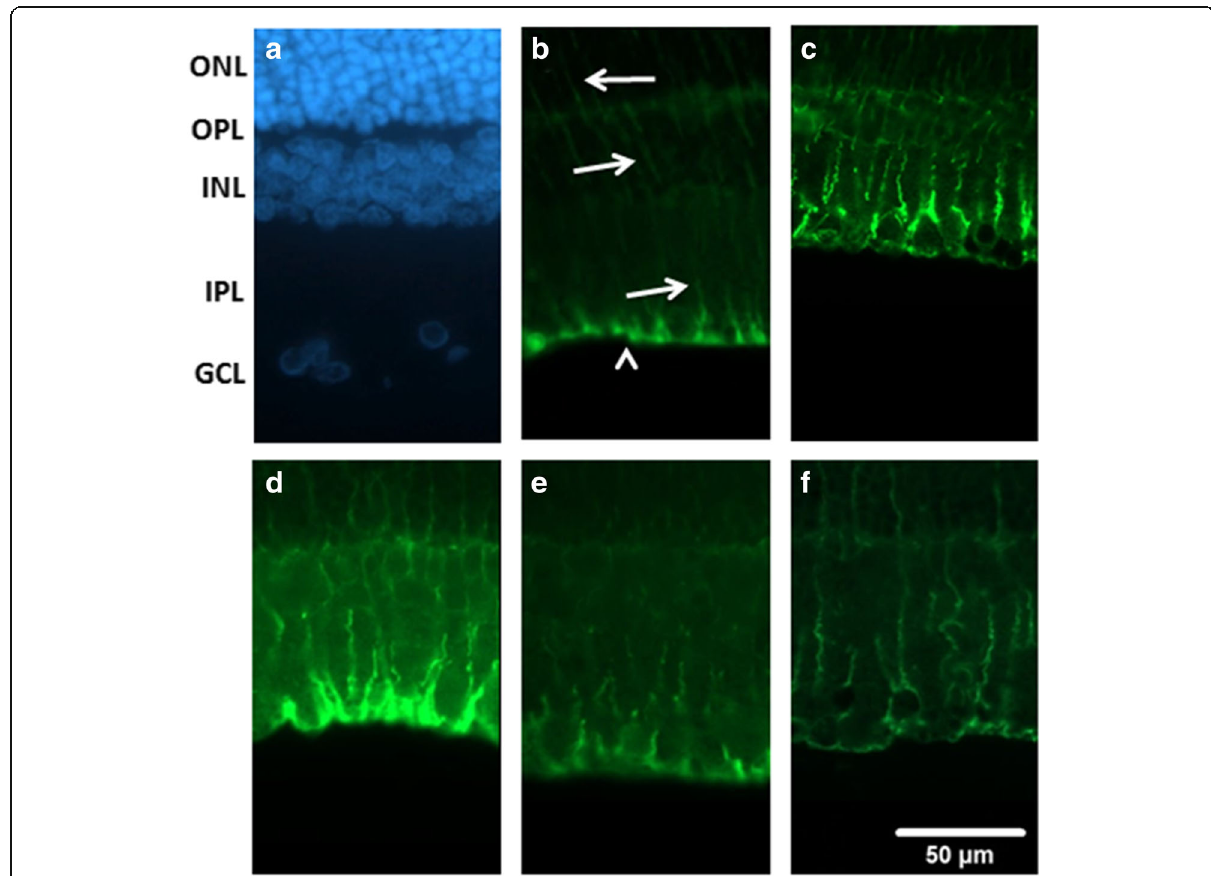
Fig. 6 Vimentin (green) immunohistochemistry. a shows the cellular nucleus of the sham retina labeled with 4,6-diamidine-2-phenylindole dihydrochloride ( DAPI, blue ). b shows a sham retina with the vimentin immunoreactivity at the end feet ( arrow heads ) in the GCL and at the processes in the IPL, INL and ONL ( arrows ). c shows a retina that received I/R and preischemia adminstration of vehicle; in contrast to the sham retina, the anti-vimentin immuolabeling has increased. ( d , e , f ) are sections from retinas that received I/R and preischemia administration of 1.35 g/kg/day XFZYD (d, XFZYD 1.35 + I/R), 2.7 g/kg/day XFZYD ( e , XFZYD 2.7 + I/R) or postischemia administration of 2.7 g/kg/day XFZYD ( f , I/R + XFZYD 2.7 ). Moreover, this ischemia-induced alteration is clearly and dose-dependently reduced when the ischemic retina is preadministrated with 1.35 and 2.7 g/Kg/day XFZYD. Postischemia administration of 2.7 g/Kg/day XFZYD also clearly attenuated this ischemia-induced alteration. ONL: outer nuclear layer, OPL: outer plexiform layer, INL: inner nuclear layer, IPL: inner plexiform layer, GCL: ganglion cell layer. Scale bar = 50 μ